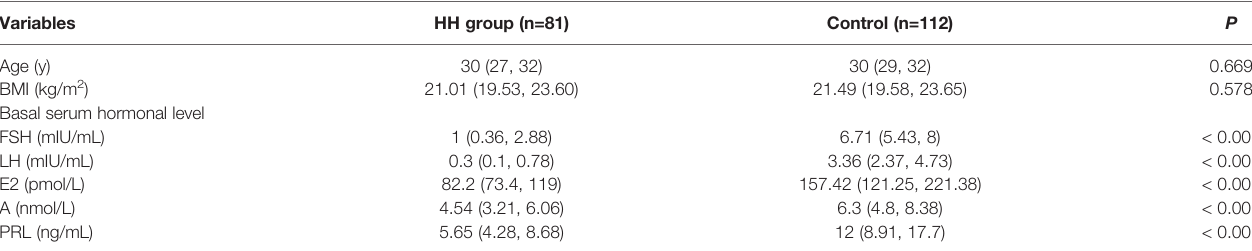
TABLE 1 | Comparison of clinical characteristics between hypogonadotropic hypogonadism (HH) and control groups. Variables